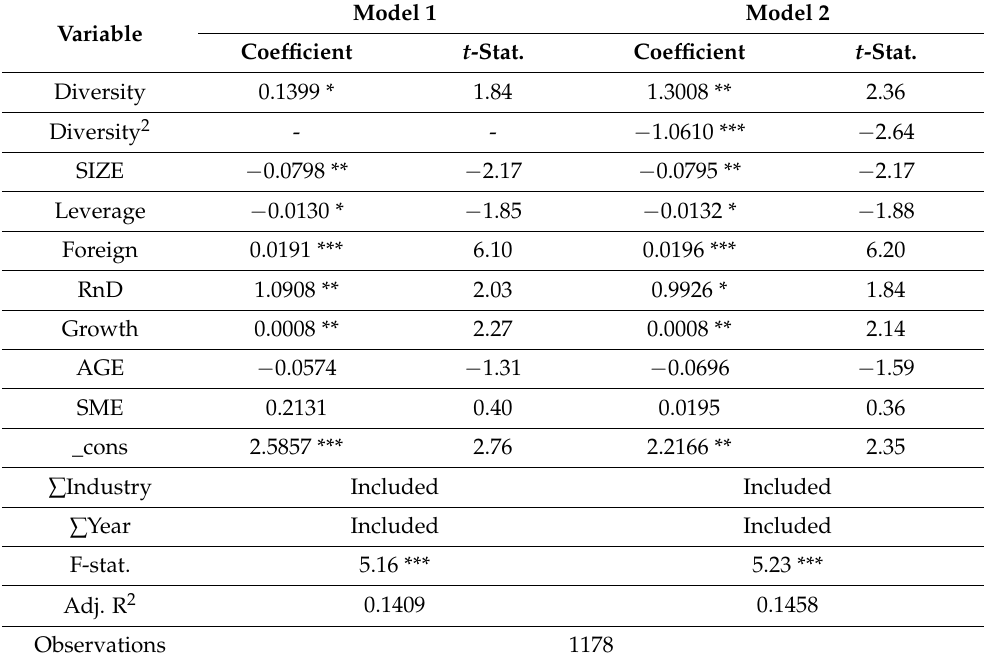
Table 3. OLS Regression Results.